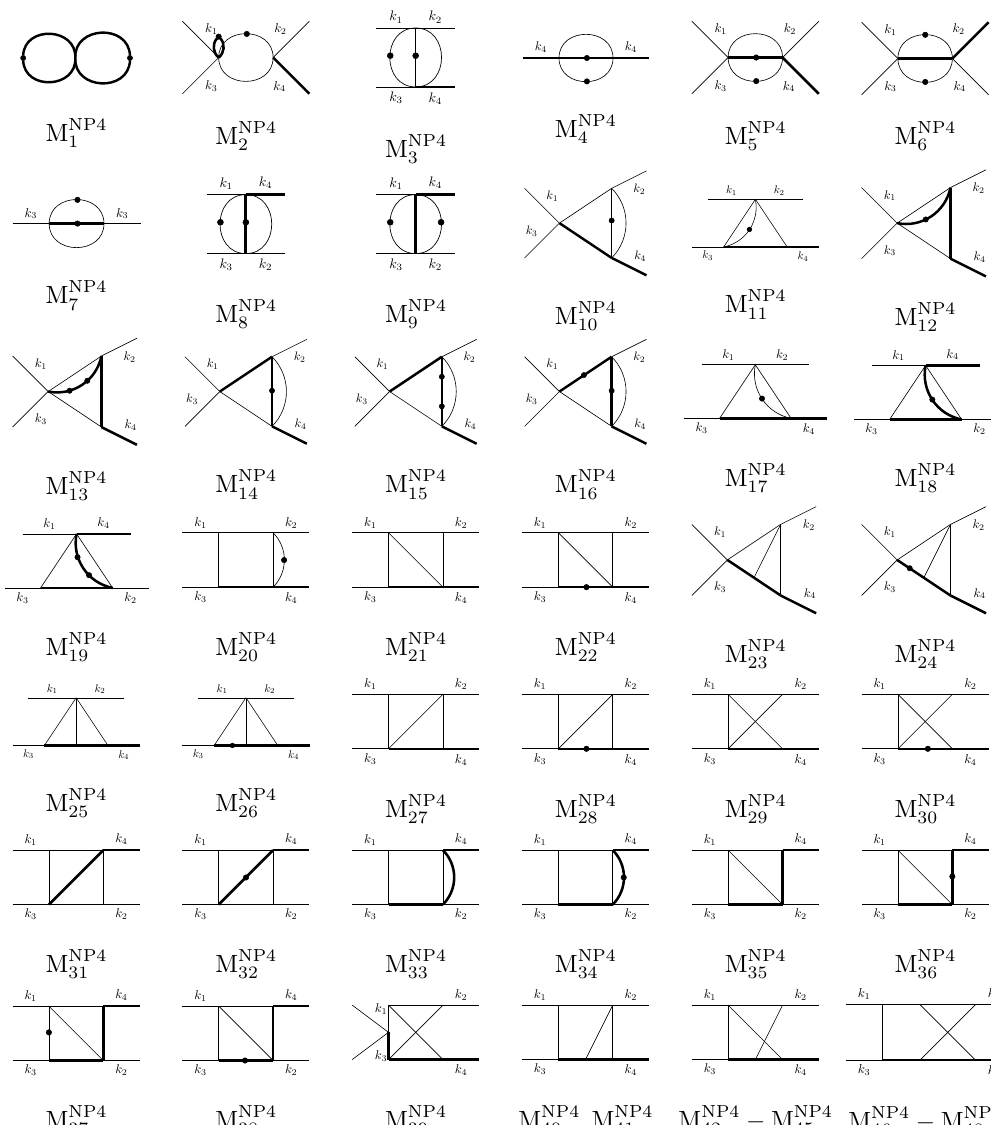
Figure 8. Master integrals in the NP4 topology. The thick lines stand for massive top quarks while the others represent massless particles. One black dot indicates one additional power of the corresponding propagator. The numerators can be found in the